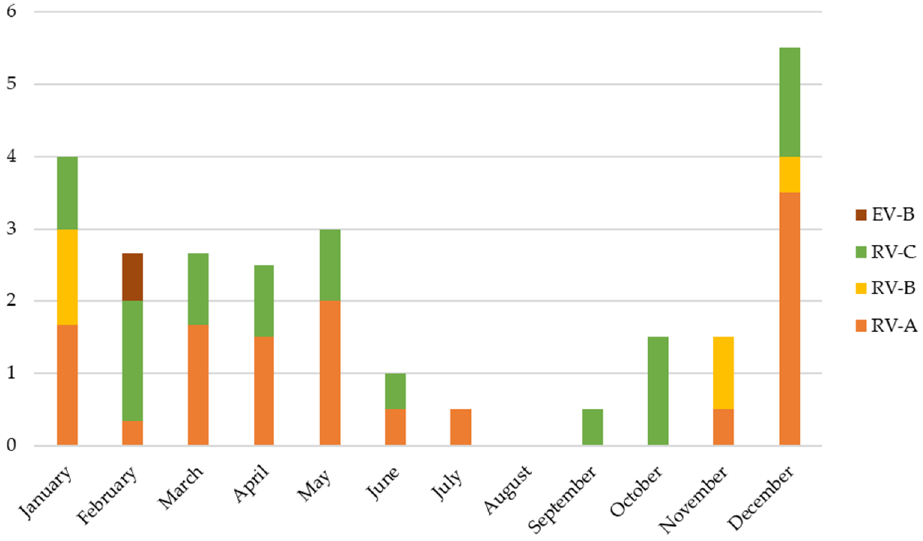
Figure 2. Viral detections and EV/RV species in each patient. MPV: human metapneumovirus; RSV: respiratory syncytial virus; RV/EV: rhinovirus/enterovirus.